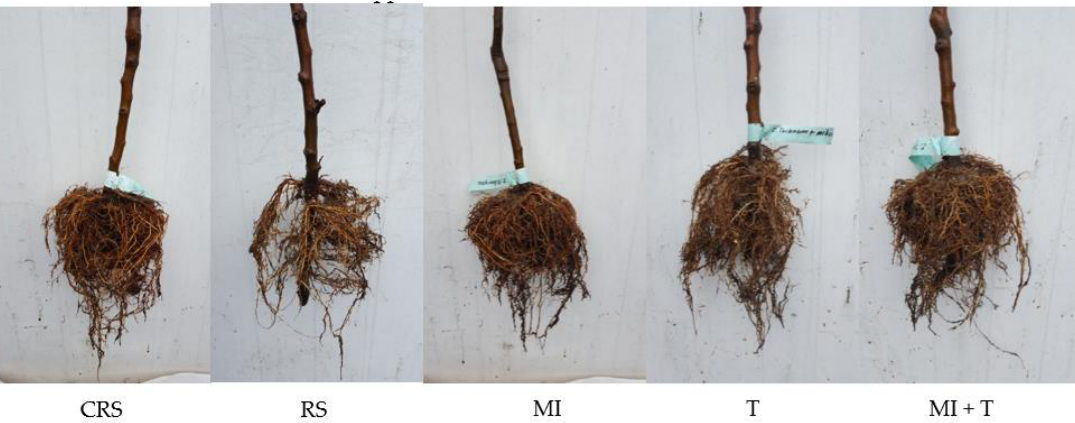
Figure 4. Root system of apple trees (CRS = crop rotation soil; RS = replanted soil; MI = mycorrhizal inoculum; T = Trichoderma ; MI + T = mycorrhizal inoculum + Trichoderma